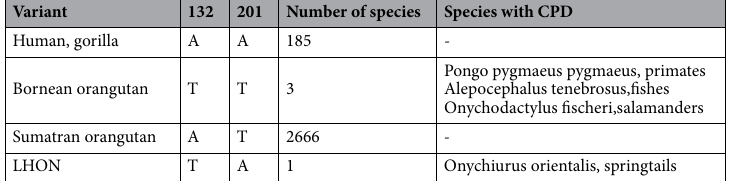
Variant 132 201 Number of species Species with CPD Human,